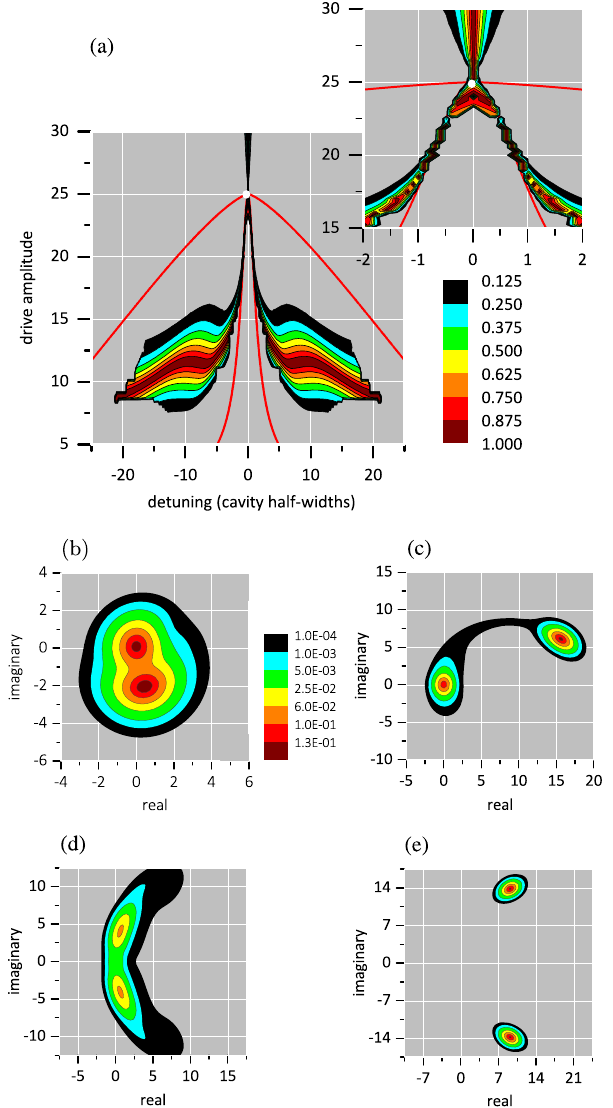
FIG. 2. (a) Region of drive-detuning-amplitude plane within which the steady-state Q function corresponding to Fig. 1 is bimodal. Contours of r ¼ 1 − j h 1 − h 2 j = ð h 1 þ h 2 Þ are shown, with h 1 and h 2 the peak heights. Red lines outline the region of bistability according to Eqs. (10) – (12), e.g., as in Fig. 4(b). (b) – (e) Sample Q functions plotted, respectively, for ð E = κ ; Δ ω = κ Þ ¼ ð 10 ; 16 Þ ; (18,1.1); (25,0);